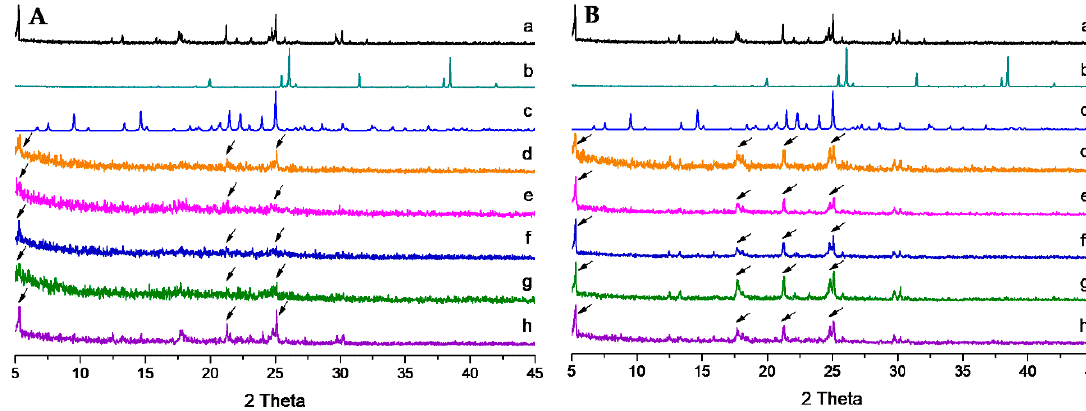
Figure 5. Comparison of PXRD patterns: ( A ) (a) NTZ, (b) SUC, (c) NTZ-SUC simulated from SCXRD data. Solids recovered after powder dissolution tests of NTZ-SUC under non-sink conditions in pH 7.5 phosphate bu ff er solution with pre-dissolved 0.5% w / v HPMC after (d) 1 min, (e) 2 min, (f) 3 min, (g) 4 min, (h) 5 min. ( B ) (a) NTZ, (b) SUC, (c) NTZ-SUC simulated from SCXRD data. Solids recovered after powder dissolution tests of NTZ-SUC under non-sink conditions in pH 7.5 phosphate bu ff er solution with pre-dissolved 0.5% w / v Methocel ® 60 HG after (d) 1 min, (e) 2 min, (f) 3 min, (g) 4 min, (h) 5 min.